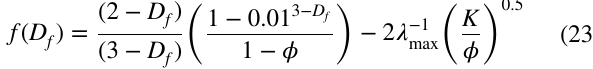
Calculated fractal dimension in the